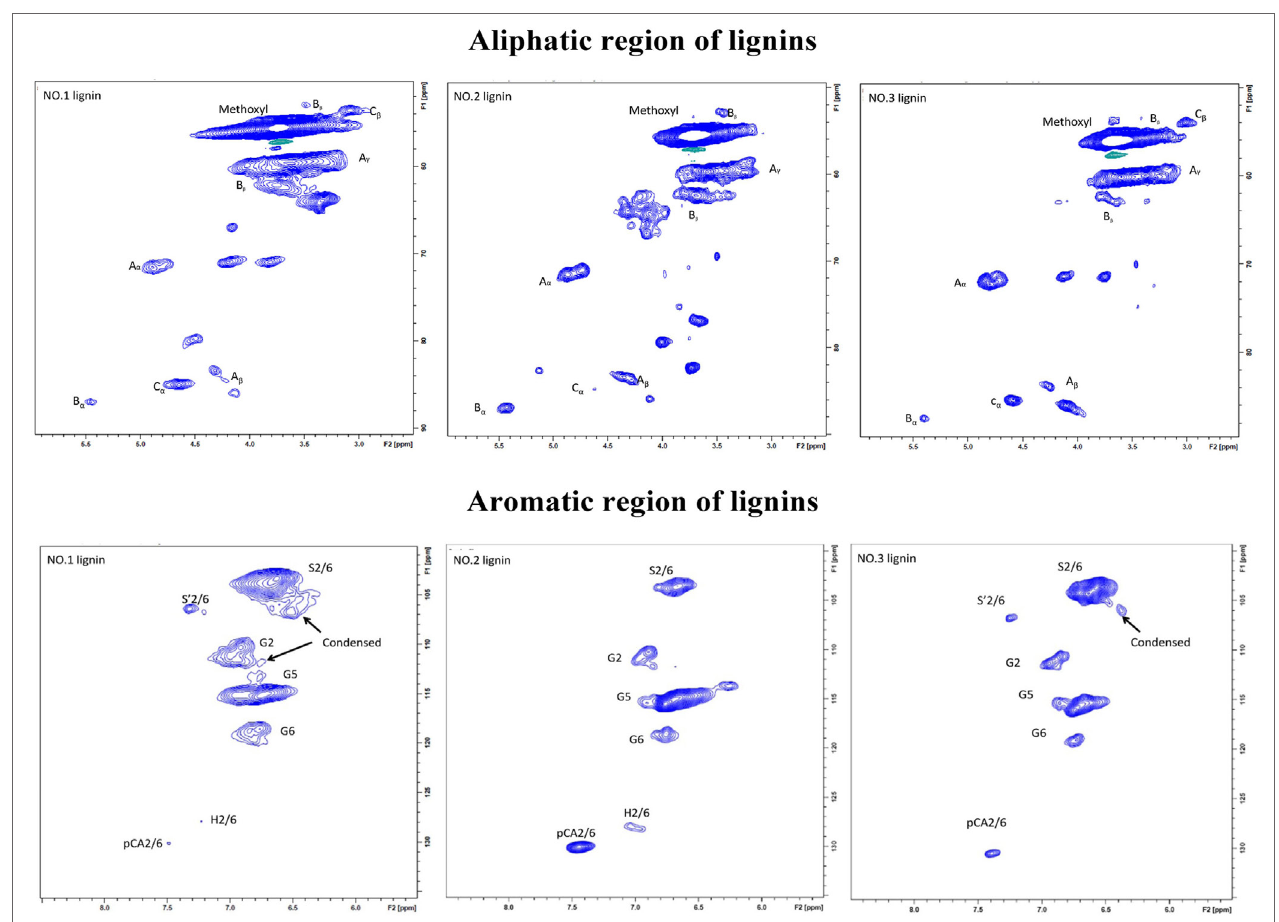
FigUre 3 | Aromatic regions ( δ C / δ H 160–90/8.0–5.5) and aliphatic regions ( δ C / δ H 90–45/6.0–2.0) in heteronuclear single quantum coherence (HSQC) spectra of the isolated lignin samples from switchgrass: (A) β - O -4 alkyl-aryl ethers; (B) phenylcoumarane; (C) resinols; ( p CA) p- coumarates; (G) guaiacyl units; (S) syringyl units; (S ′ ) oxidized syringyl units with a C α